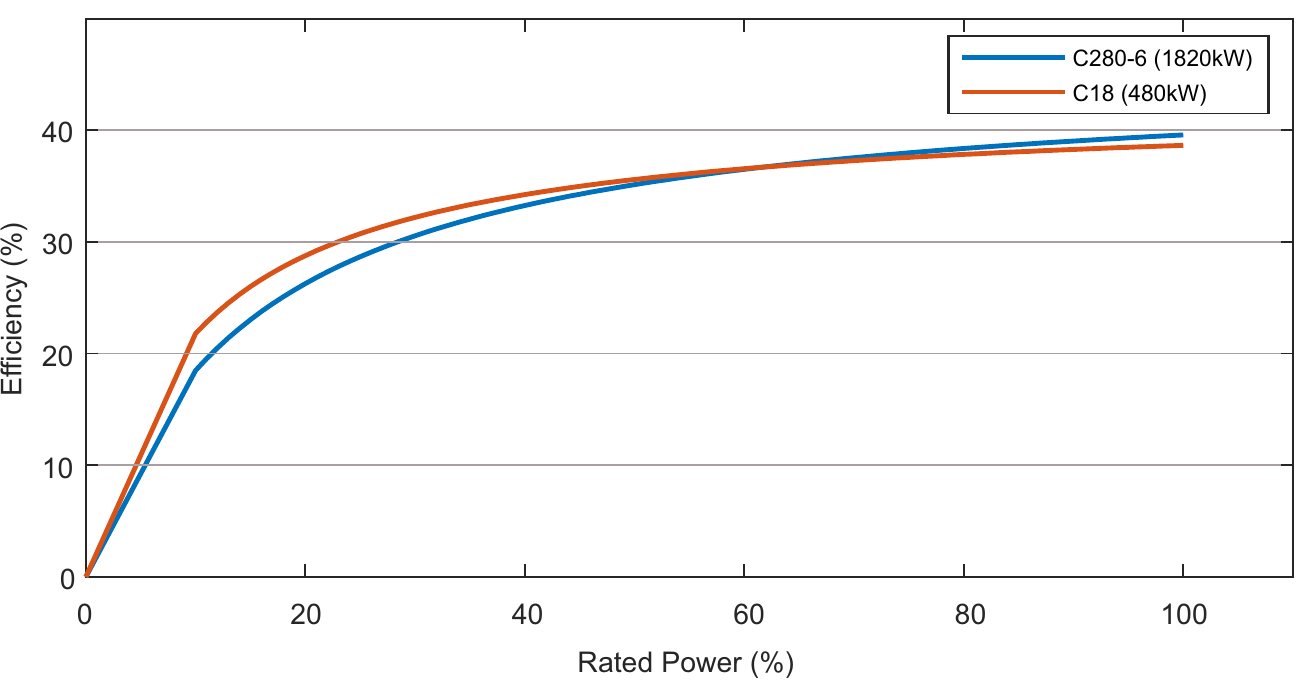
Figure 7. Efficiency curve of the main and auxiliary diesel engines, these curves were obtained from [31,32],